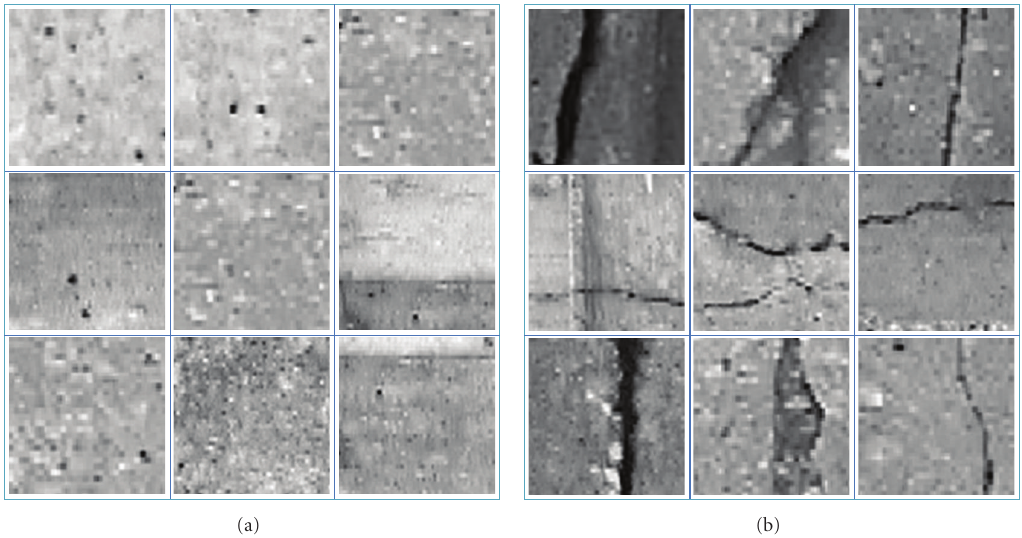
Figure 1: Example concrete surface images: (a) concrete surfaces with normal finish; (b) concrete surfaces with evident cracks.